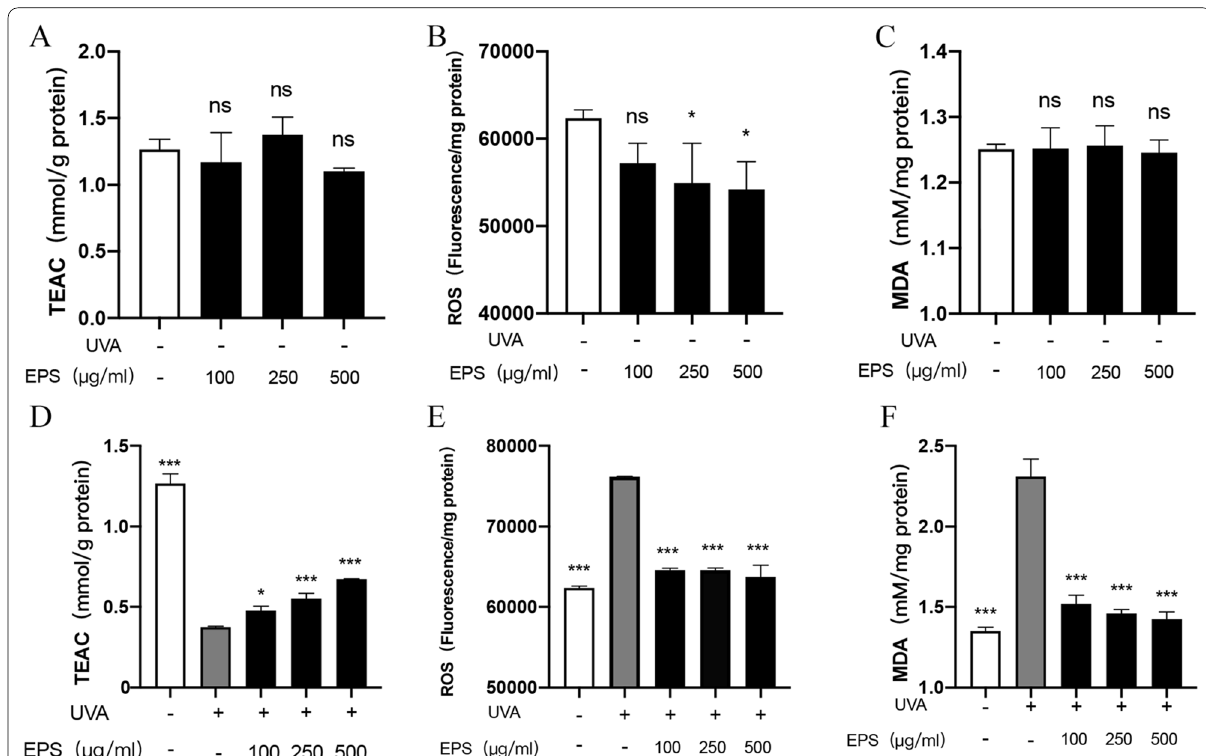
Fig. 3 Effects of different concentrations of EPS on total antioxidant capacity (ABTS), ROS scavenging capacity and MDA content: A Determination of Trolox Equivalent Antioxidant Capacity (TEAC) under normal conditions; B Fluorescence intensity of HSF under normal conditions; C Malondialdehyde content of HSF under normal conditions; D Determination of Trolox Equivalent Antioxidant Capacity (TEAC) under UVA irradiation; E Fluorescence intensity of HSF under UVA irradiation; F Malondialdehyde content of HSF under UVA irradiation. * p < 0.05, ** p < 0.01, *** p < 0.001 compared to model